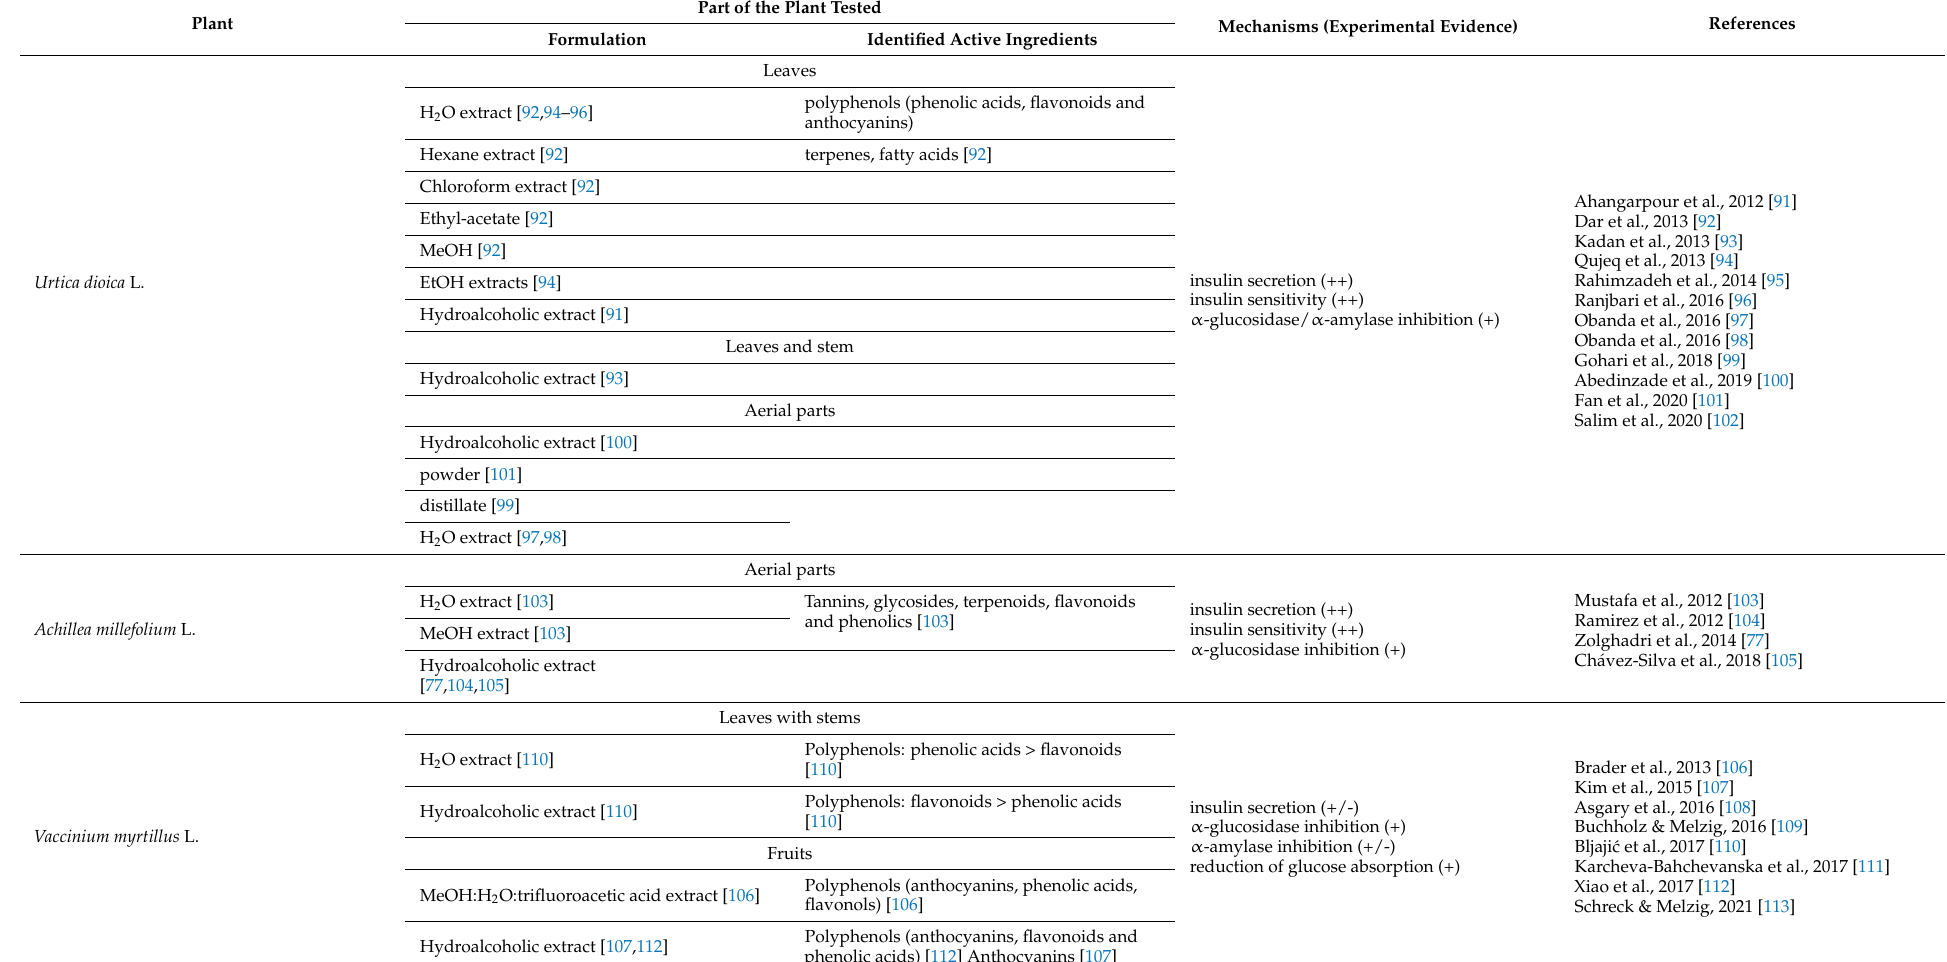
Table 2. Plants used in the Occitan valleys of the Piedmont Alps: potential direct anti-diabetic mechanisms (experimental evidence between 2011 and 2021).